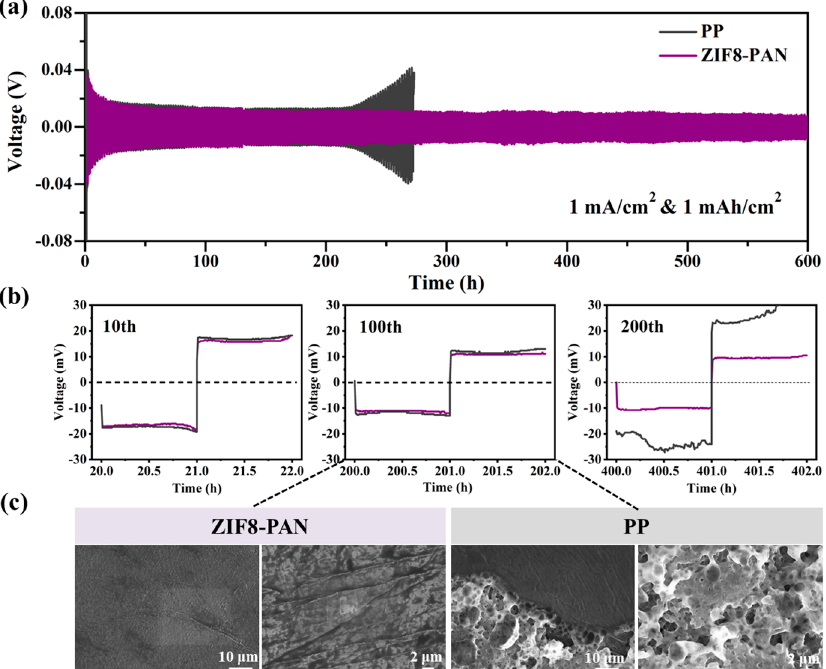
Figure 6. ( a ) The cycling stability of the Li//Li symmetric cells assembled with PP and PAN separators under current density of 1.0 mA/cm 2 with area capacity of 1.0 mAh/cm 2 at 25 °C. ( b ) Corresponding magnified voltage profiles at the 10th, 100th and 200th cycle. ( c ) The SEM analysis of 100th cycled Li electrodes tested in Li//Li symmetric cells using certain separator.